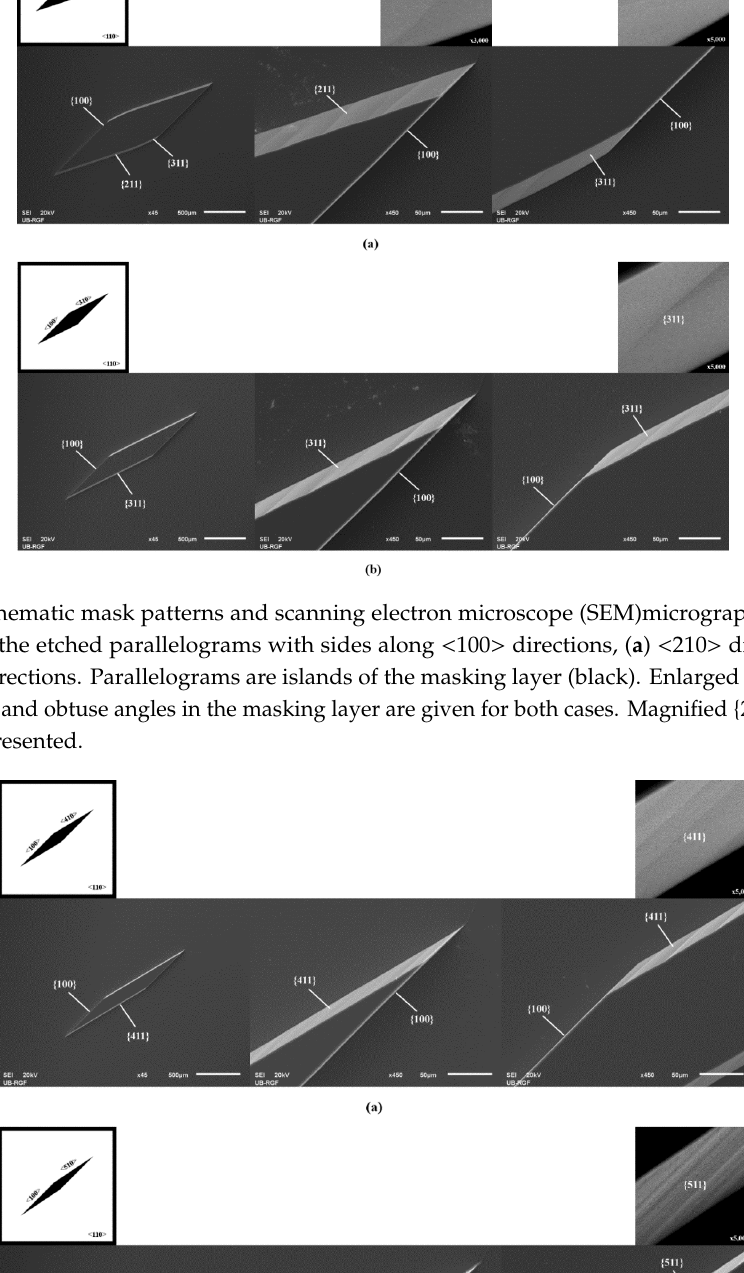
Figure 2. Schematic mask patterns and SEM micrographs (standard Si wafer) of the etched parallelograms with sides along < 100 > directions, ( a ) < 410 > directions and ( b ) < 510 > directions. Parallelograms are islands of the masking layer (black). Enlarged details of the etched acute and obtuse angles in the masking layer are given for both cases. Magnified {411} and {511} planes are presented.